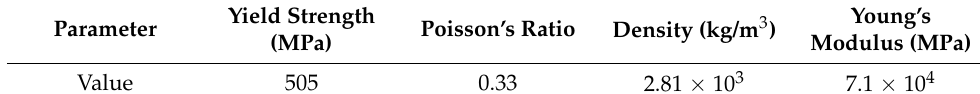
Table 3. Properties of Al7075-T6.